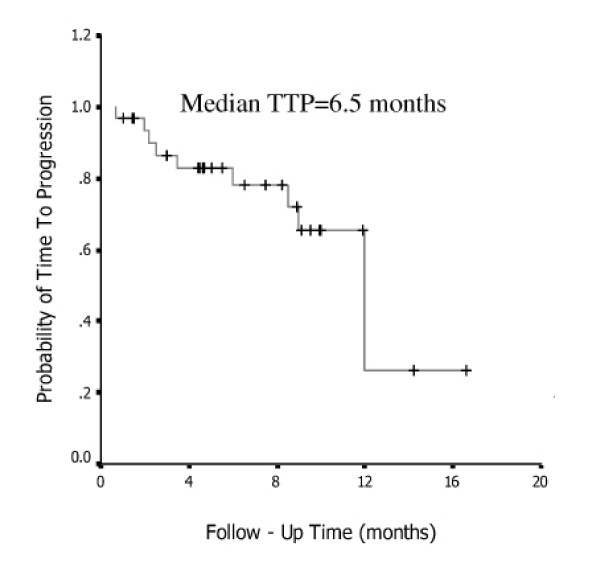
Time to progression of 33 patients treated with gefitinib.